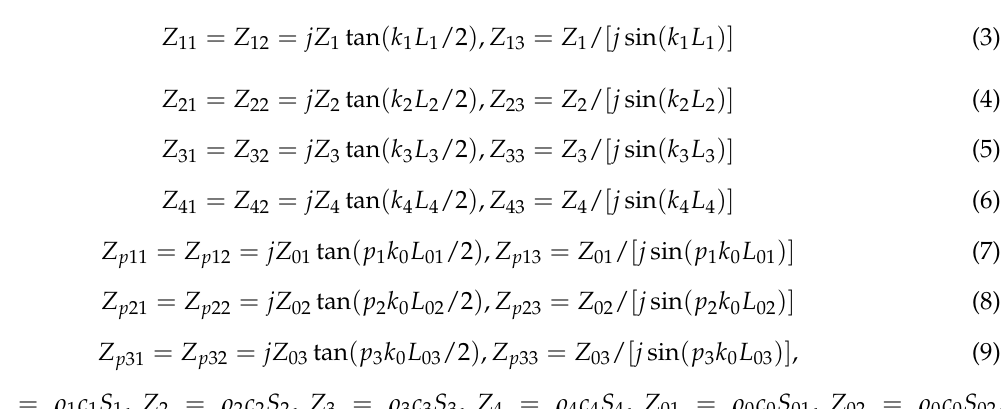
Figure 3. Electromechanical equivalent circuit of the cascaded piezoelectric ultrasonic transducer with three sets of piezoelectric ceramic stacks.